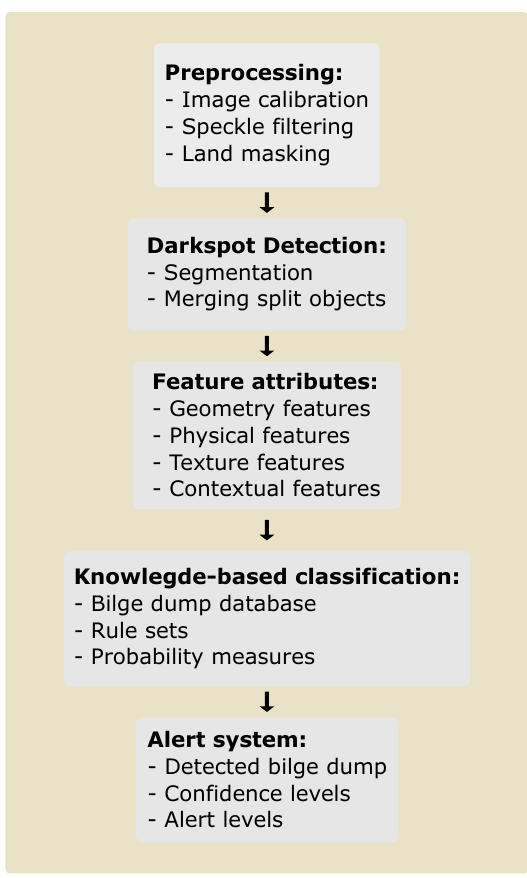
Figure 2. Bilge dump event alert system